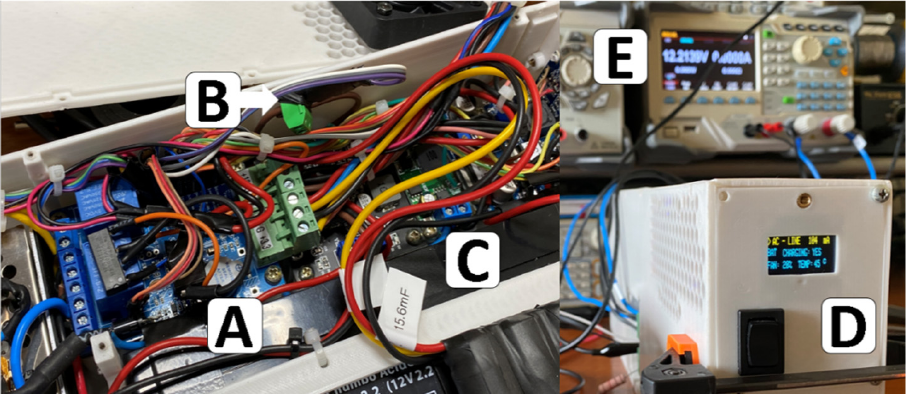
Figure 17. The setup to test the current profile: A—MCU board, B—Hall effect sensor, C—Bipolar symmetric regulator, D—Power supply, E—Electronic load.